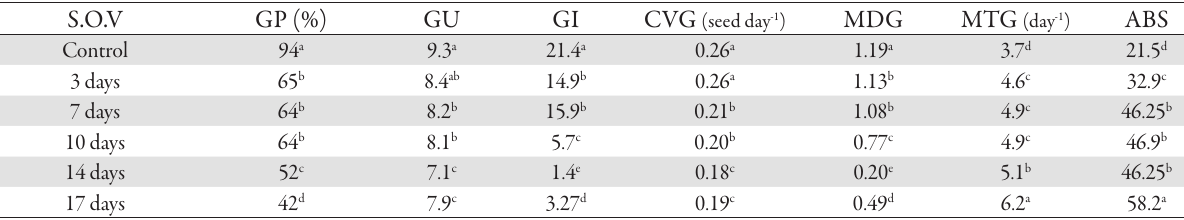
Tab. 2. Means comparison of germination indexes as affected by deterioration time in soybean